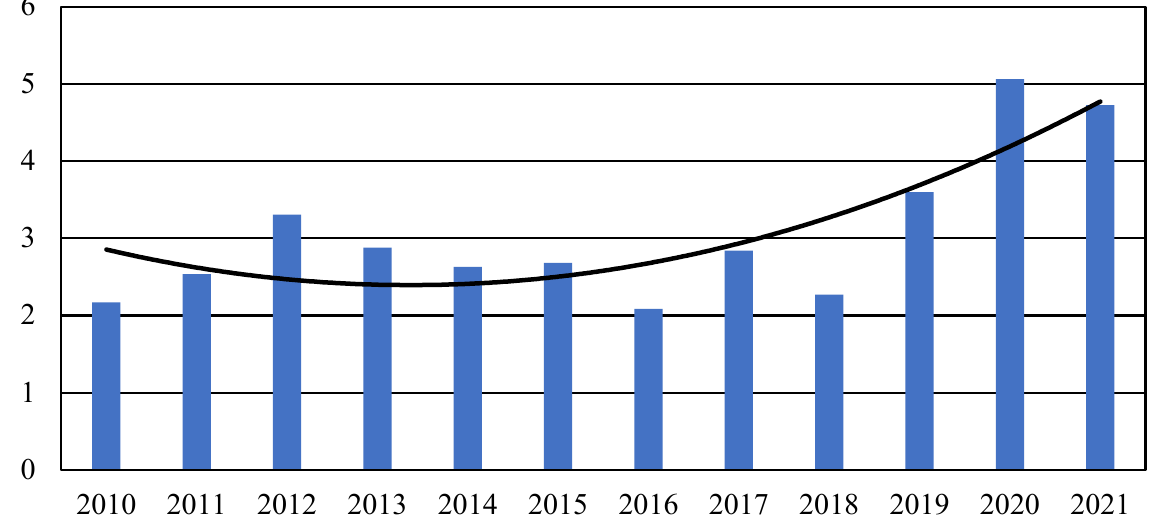
Figure 6. The potential of biodiesel production from oil-crop waste (bran) in Lithuania (thous. t.).